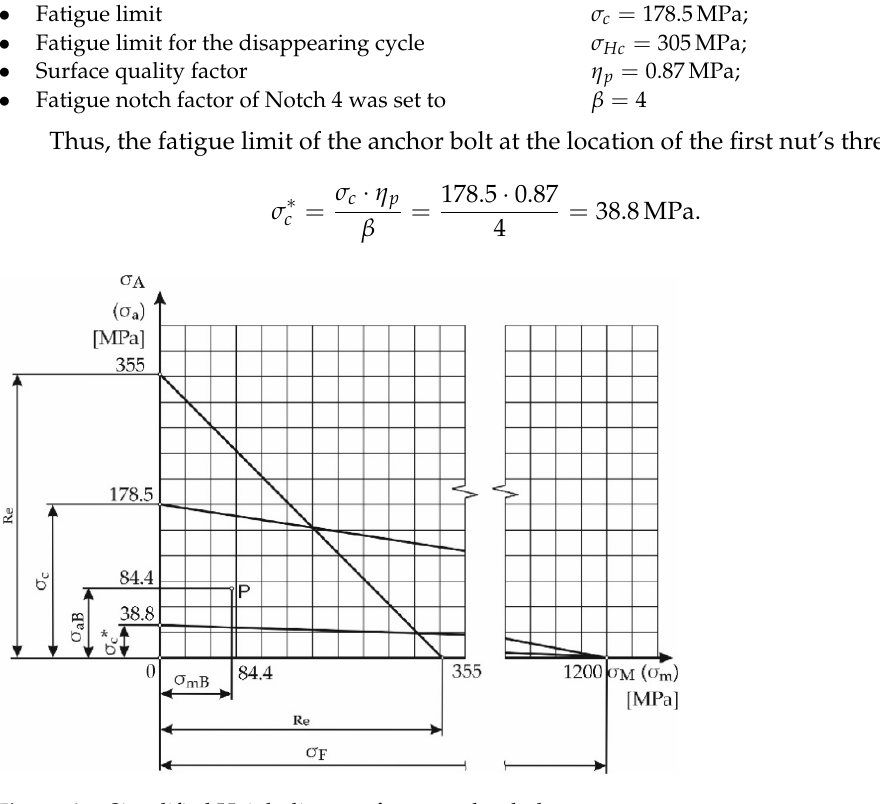
Figure A1. Simplified Haigh diagram for an anchor bolt.